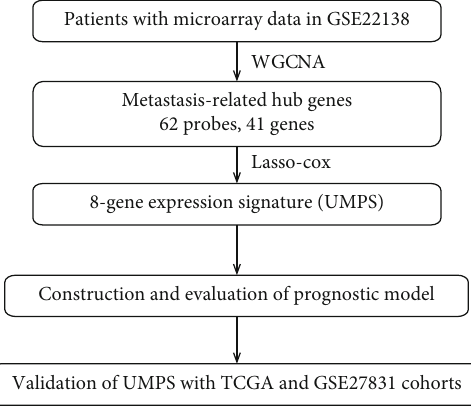
Figure 1: Flow chart of study